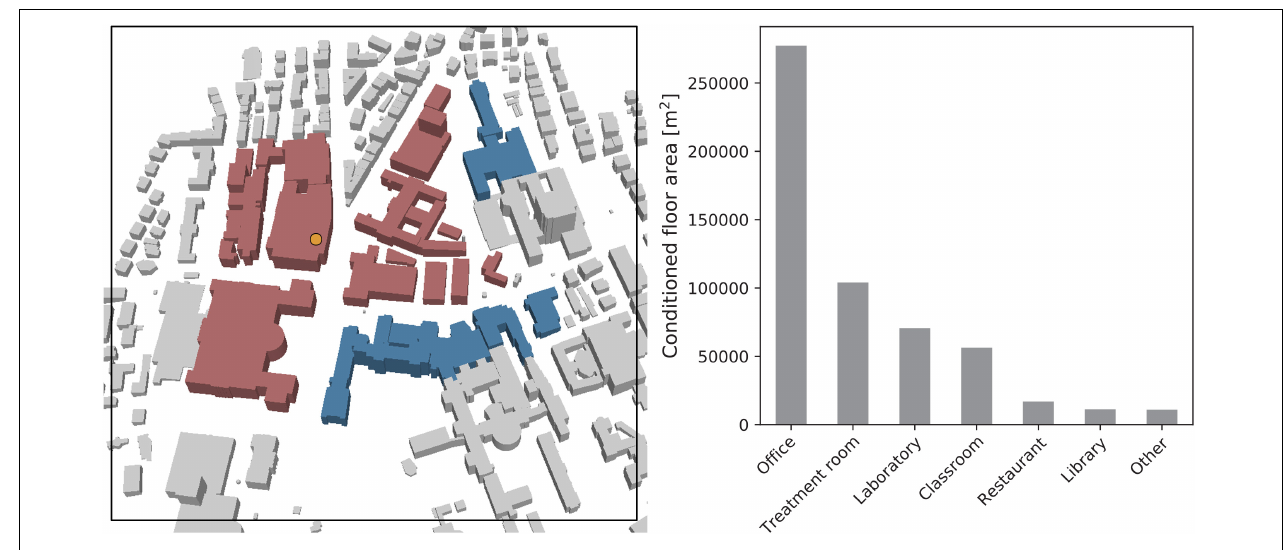
FIGURE 3 | Aerial representation of the case study area and functional distribution of the buildings under consideration. The functions shown as “Office” include both research and hospital spaces. The buildings selected for this study are colored red for university buildings and blue correspond to the hospital. The yellow circle marks the location of the temperature sensor in the case study